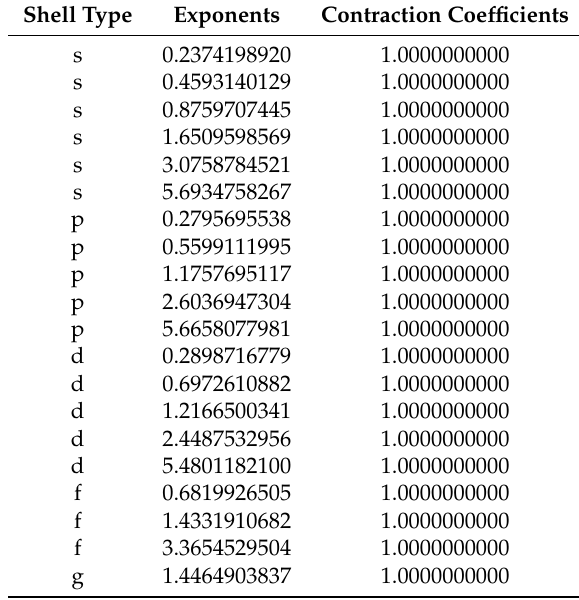
Table A27. Parameters of the cc-TZVP auxiliary basis set of